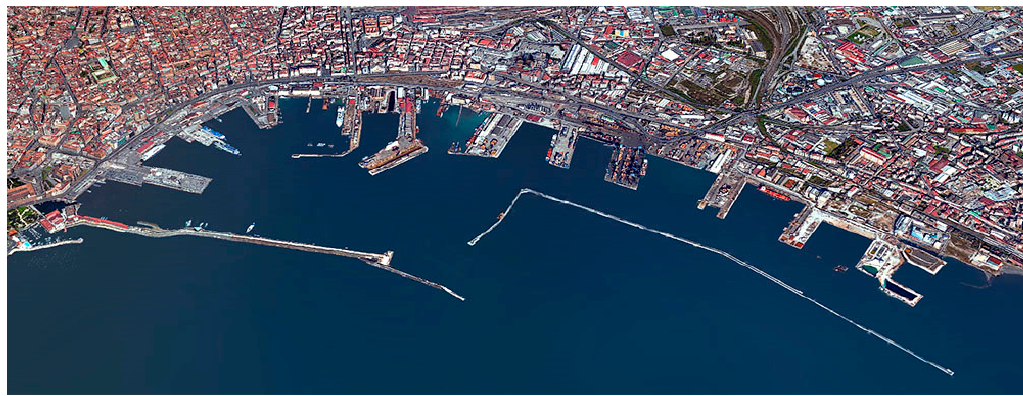
Figure 2. Naples Harbor view.